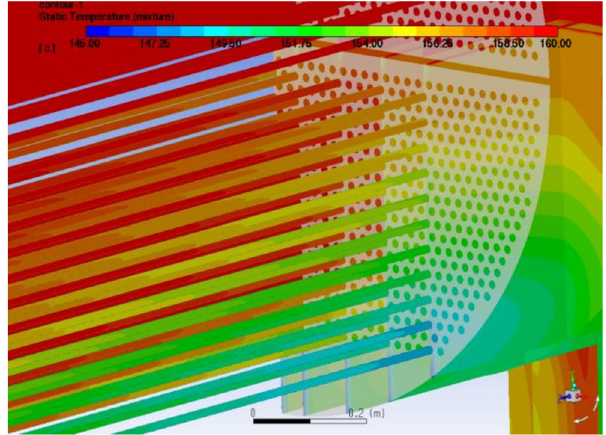
Figure 18. Temperature distribution in the outlet